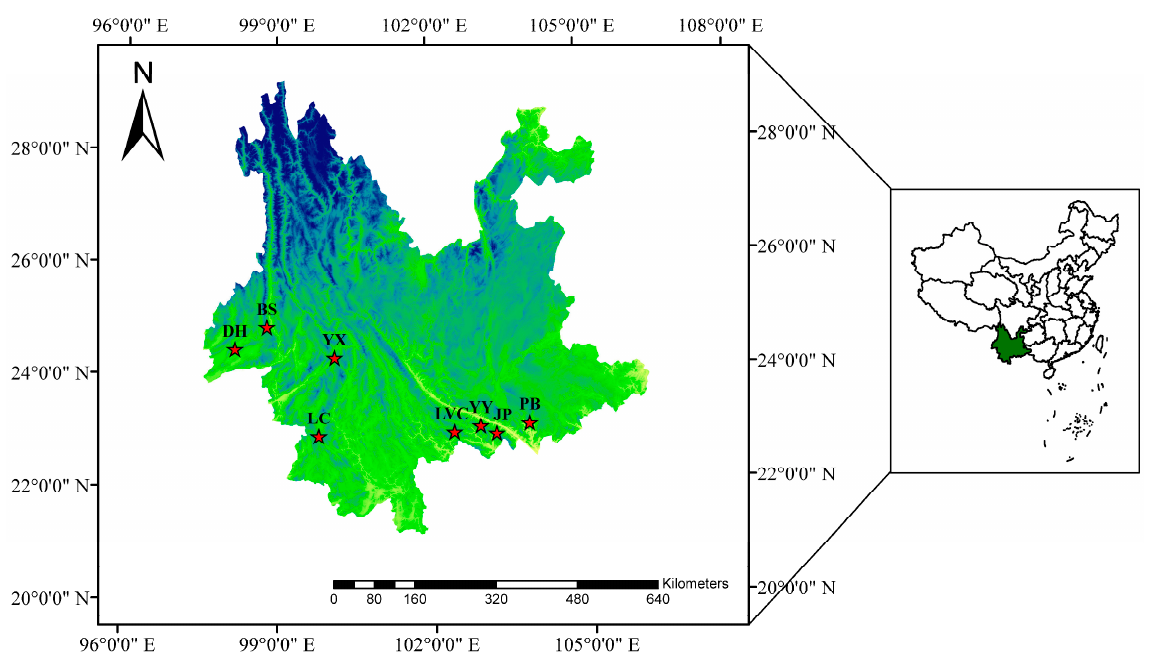
Figure 2. Sampling locations of A. tsao-ko are indicated by red stars. JP = Jinping population (13 accessions), PB = Pingbian population (13 accessions), LVC = Lvchun population (12 accessions), YY = Yuanyang population (12 accessions), LC = Lancang population (13 accessions), XY = Yunxian population (12 accessions), BS = Baoshan population (11 accessions), and DH = Dehong population (10 accessions).